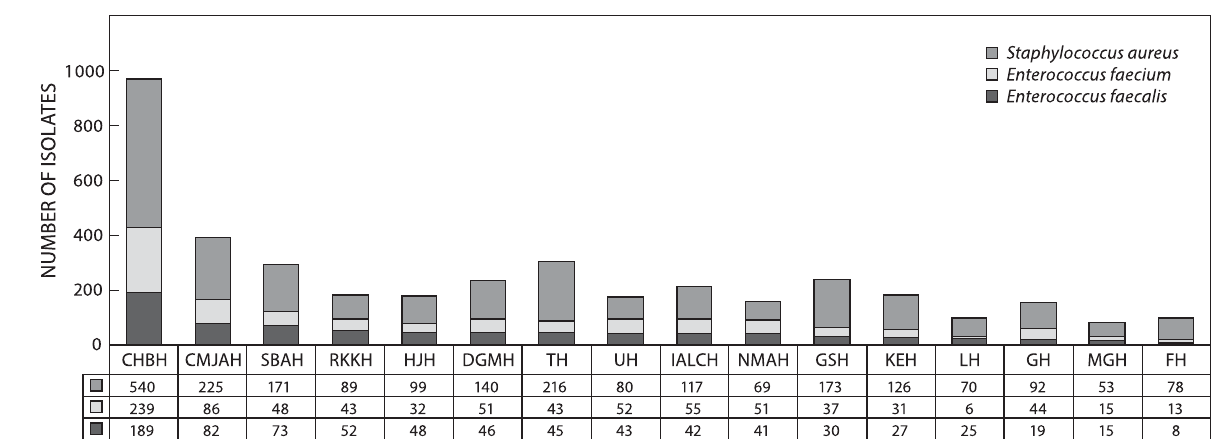
Figure 5: Number of Gram-positive bacteria: Enterococcus faecalis ( n = 785), Enterococcus faecium ( n = 846) and Staphylococcus aureus ( n = 2 338) reported from 16 sentinel hospitals across South Africa, January 1, 2016 to December 31, 2016.